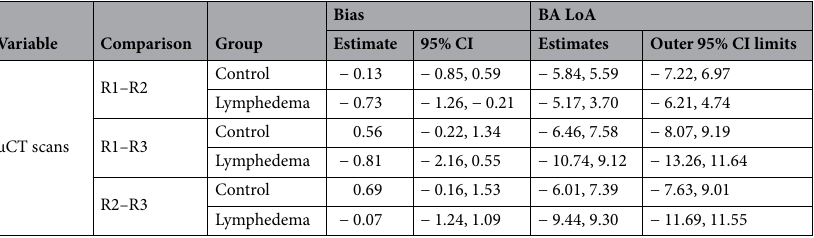
Table 1. Bias and BA LoA estimates with 95% CIs for interrater comparisons of µCT-scans. Data is presented as estimated mean difference and respective 95% confidence interval in cubic millimeters (mm 3 ), supplemented by Bland–Altman Limits of Agreement. Bland–Altman Limits of Agreement is the mean difference ± 1.96 standard deviation of the difference. BA Bland–Altman, LoA Limits of Agreement, CI